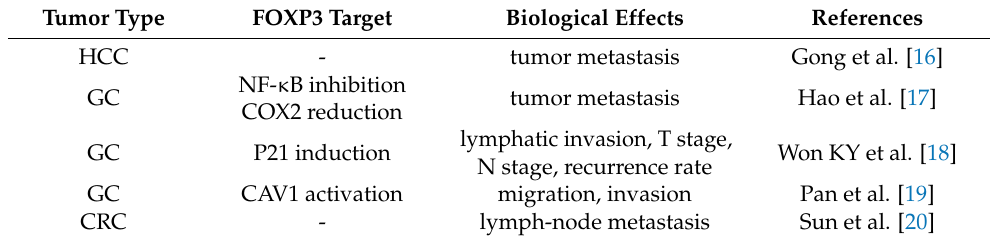
Table 1. FOXP3 acts as a suppressor in digestive system tumors.